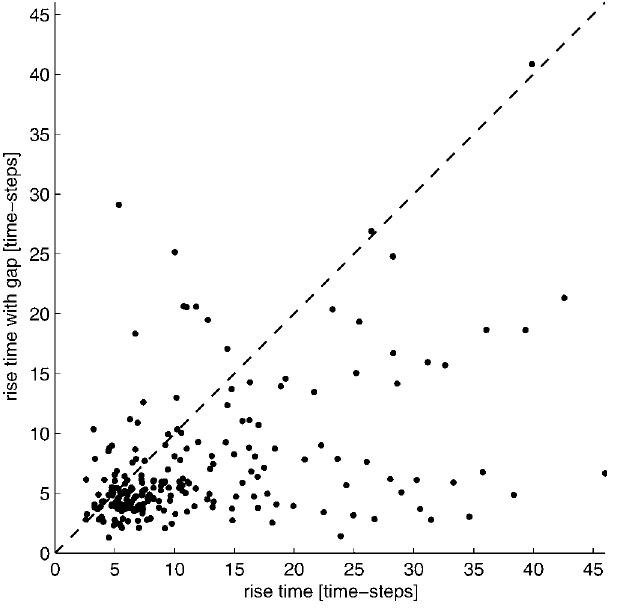
Figure 5. Network